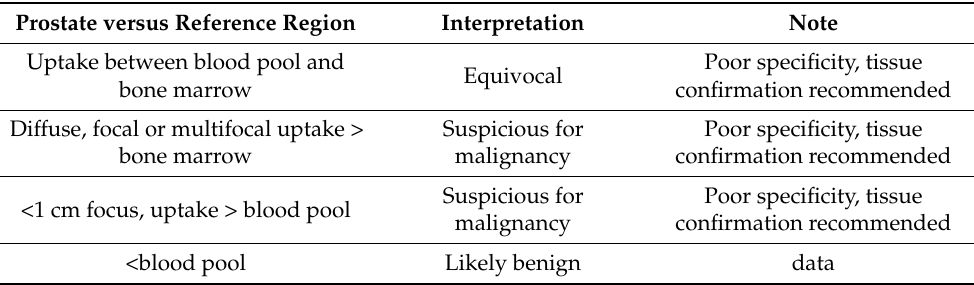
Table 3. Prostate (intact). Interpretive criteria for 18 F fluciclovine (Axumin ® ) for the prostate in patients with an intact prostate post definitive treatment. This includes patients who have had brachytherapy, external beam radiotherapy or other ablative therapy, such as cryotherapy *.